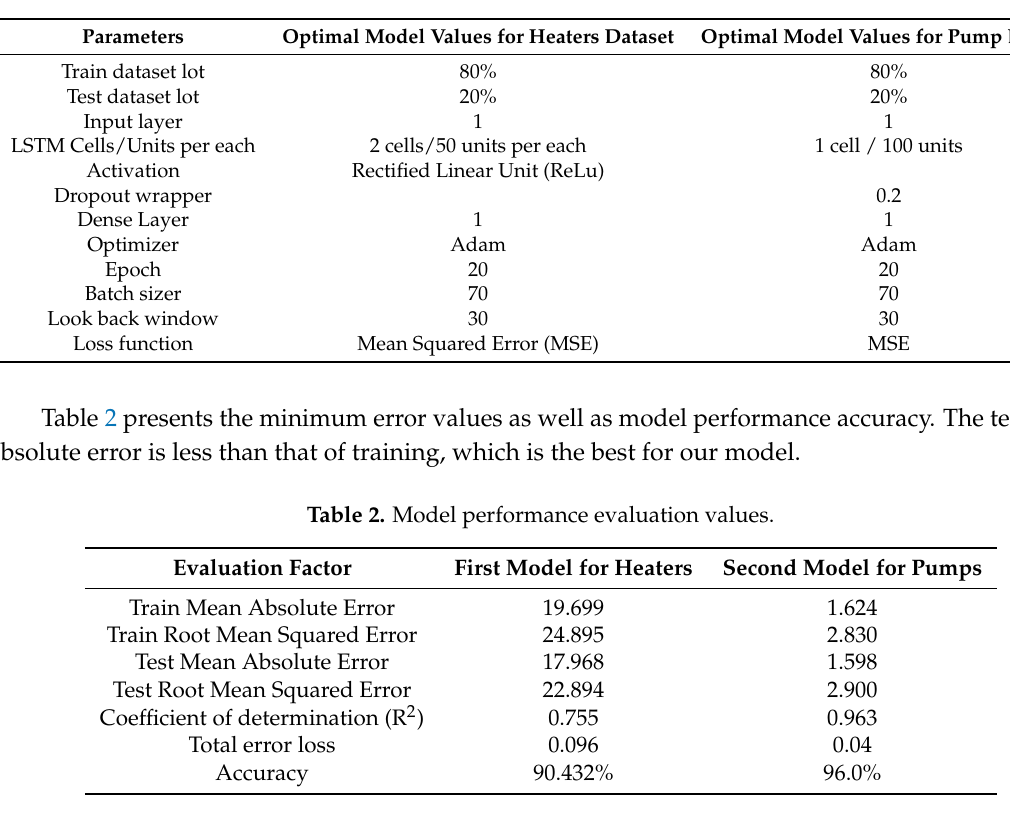
Table 1. Model parameters optimal values in experiment.